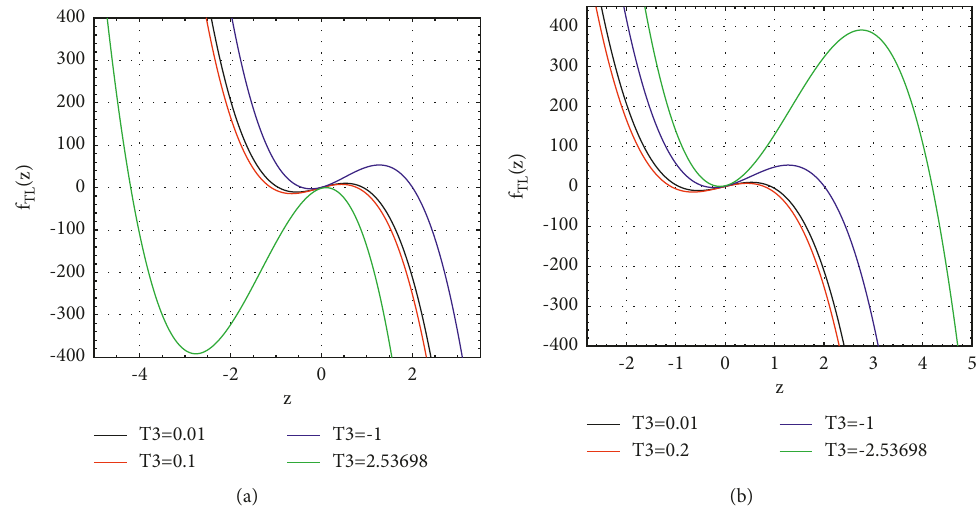
Figure 1: Dynamical behaviors of equations (6a–6c) when the parameters are σ � 1.57; β � 0.03; u � 0.009; c � 30; and v �